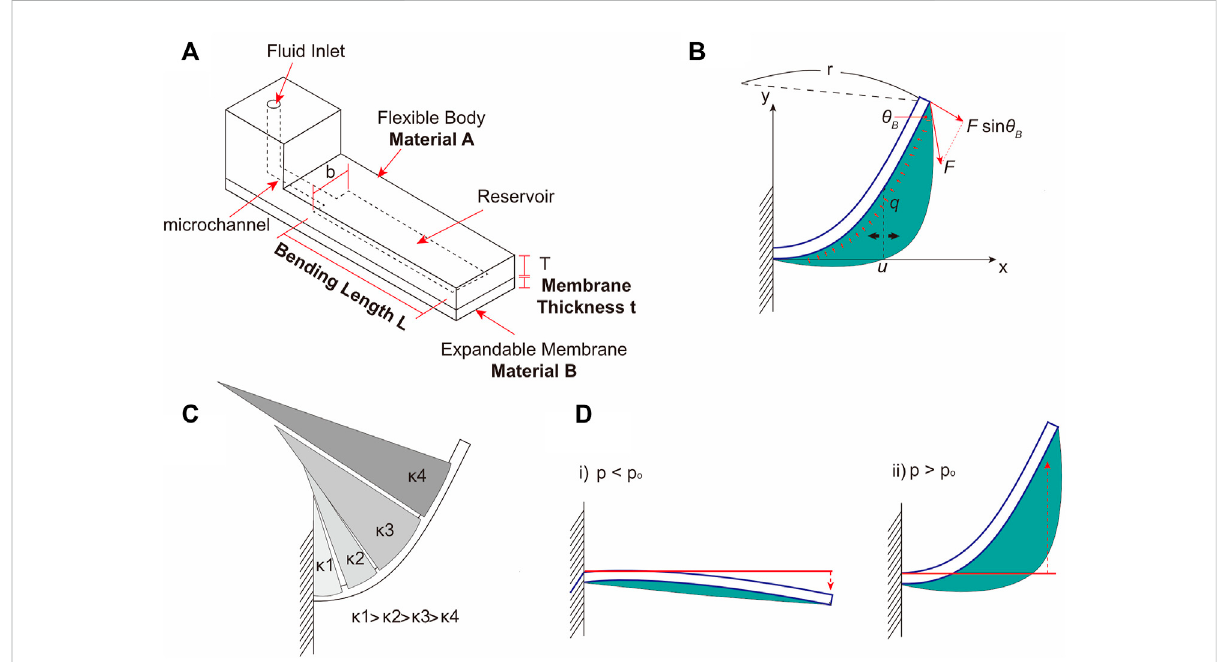
FIGURE 2 The design and working of balloon actuator. (A) Schematic of balloon actuator showing various components – Chamber length L, membrane thickness t, Materials A and Bare thematerialsconstituting theBody A and Body B, respectively. (B) Freebody diagramof balloon actuator. The thick bluelineindicatesthe fl exiblebody,andthegreenareaindicatesthesurfaceoftheexpandablemembrane.Redarrowsrepresenttheforcesactingon a fl exible body. (C) Bending shape of the balloon actuator according to the change in curvature. (D) Illustration of two bending cases during membrane expansion. The bending direction of the body is decided by the degree of membrane